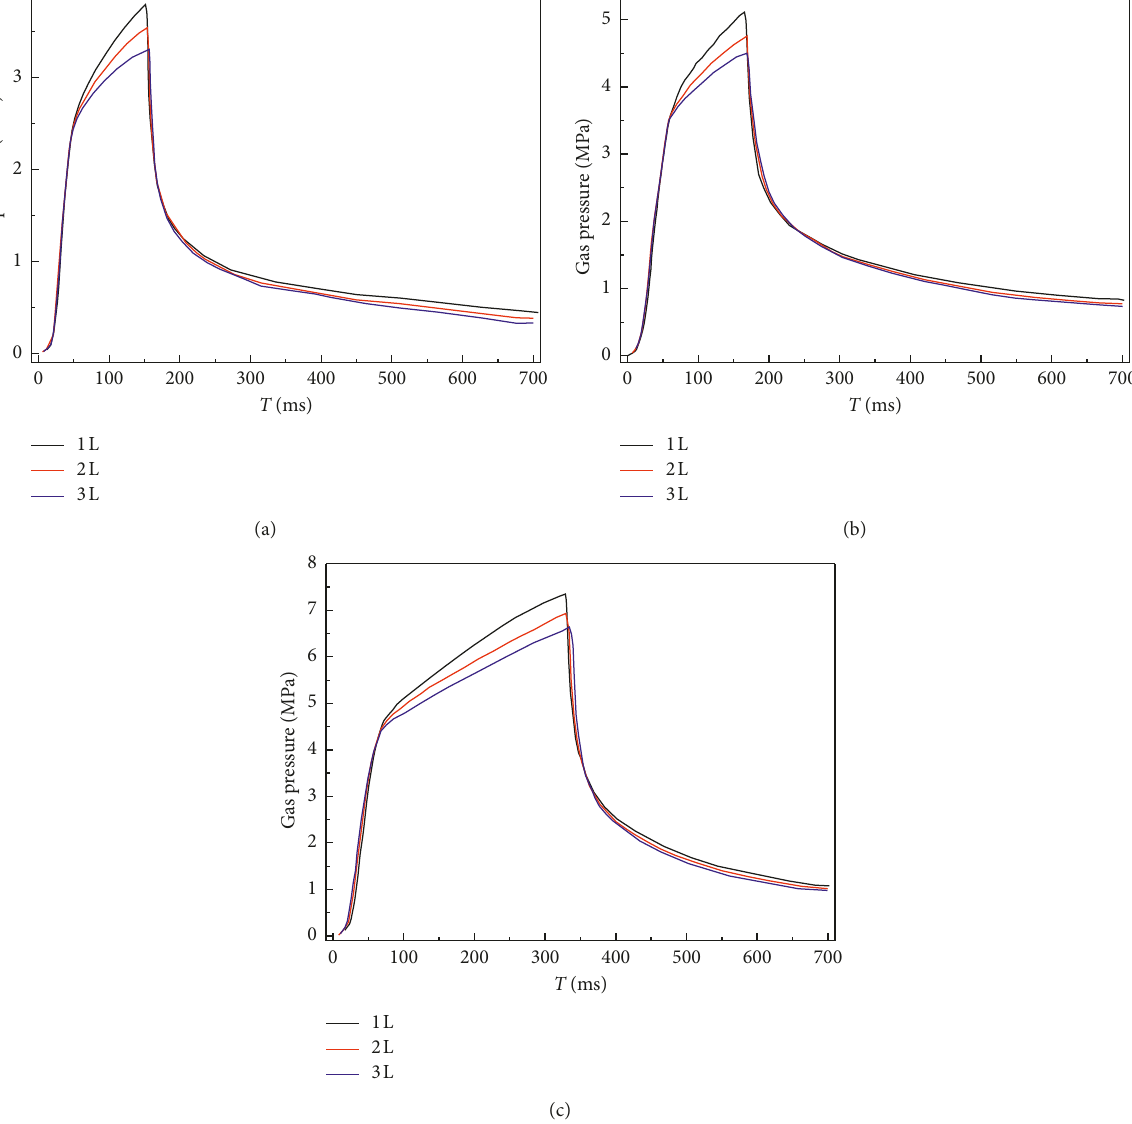
Figure 8: p - t curve of high-pressure nitrogen fracturing under different design gas volume conditions: (a) V � 1L, (b) V � 2L, and (c) V � 3L. Table 4: The length of each stage and the experimental block cracking pressure and breaking pressure. Volume of